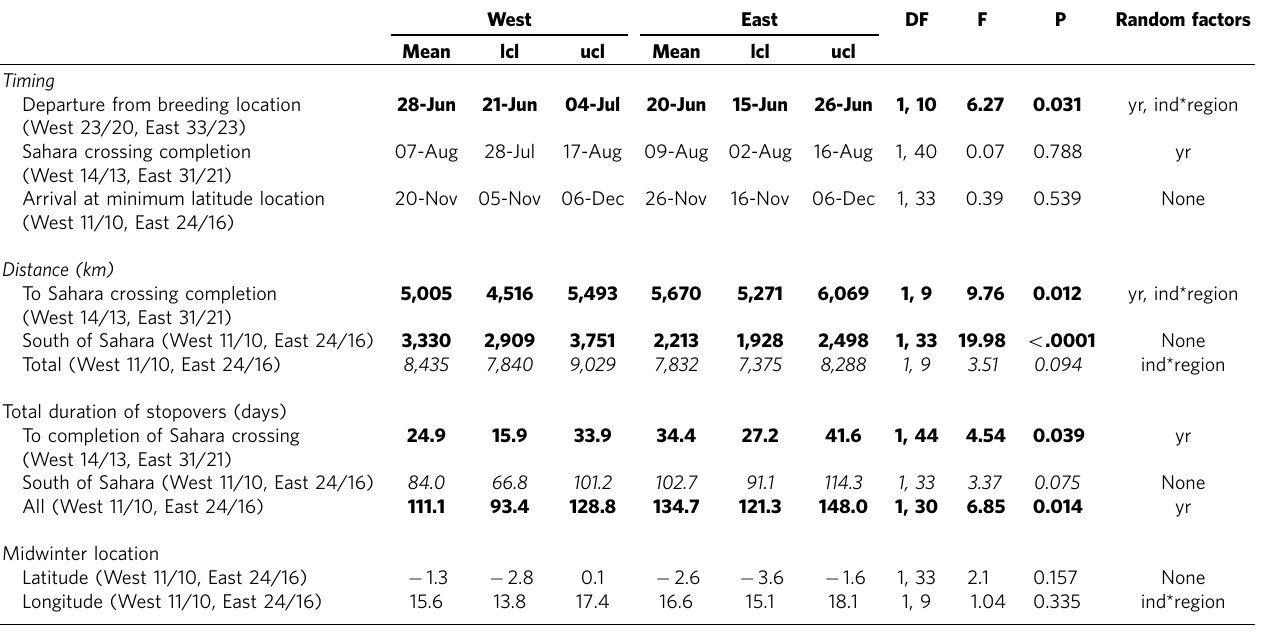
Table 1 | Comparison of migrations through the Western and Eastern routes.